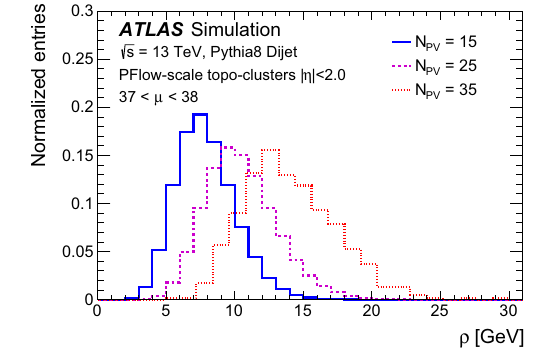
Fig. 3 Per-eventmedian p T density, ρ ,at N PV = 15(solid), N PV = 25 (long dashed), and N PV = 35 (short dashed) for 37 < μ < 38 as found in MC